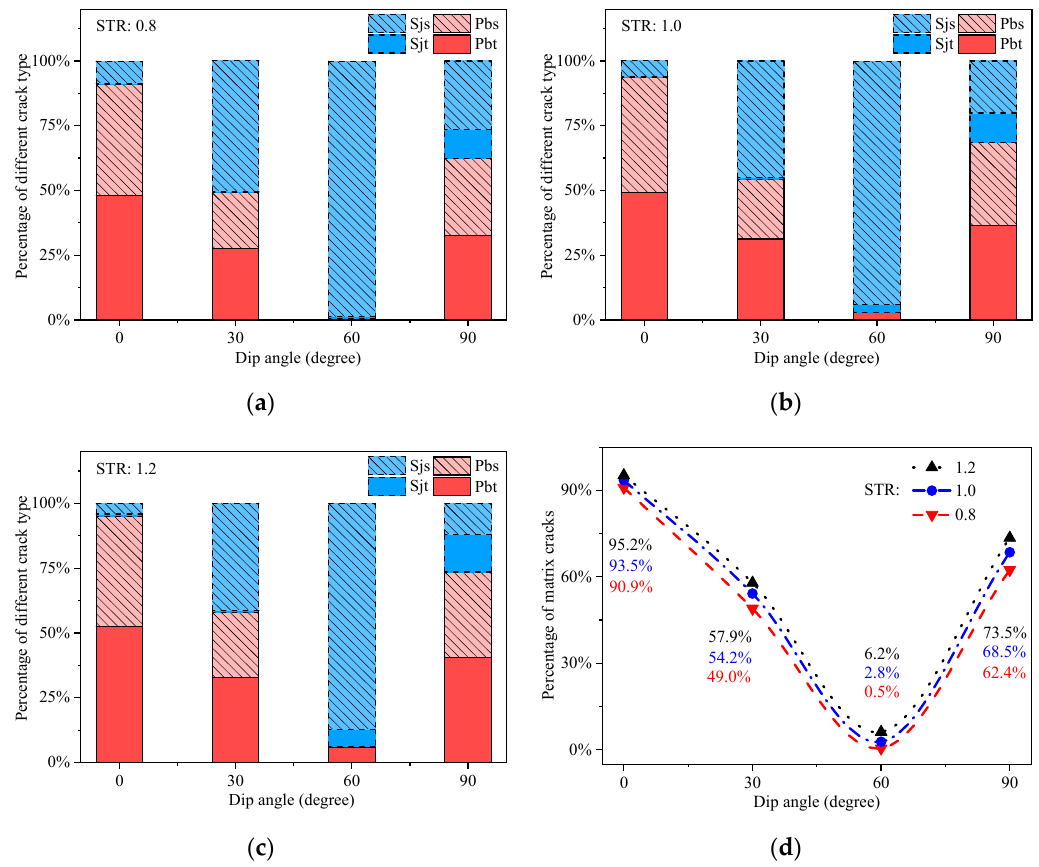
Figure 13. Effects of shear-tensile strength ratio (STR) on the crack types in uniaxial compression. ( a ) STR = 0.8; ( b ) STR = 1.0; ( c ) STR = 1.2; ( d ) comprehensive comparison of matrix cracks